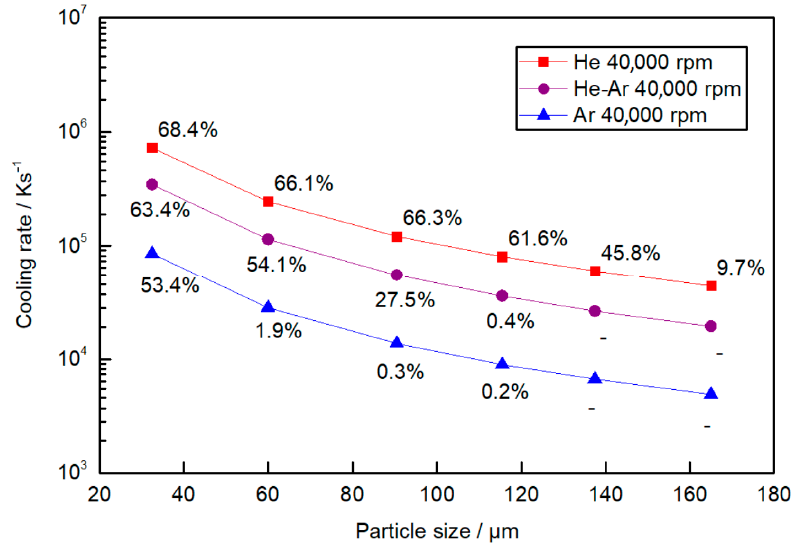
Figure 9. Cooling rate as a function of particle size atomized in a He, Ar, and He-Ar atmospheres at a disk speed of 40,000 rpm. The data points represent the amorphous fraction calculated from the DSC results for the corresponding mean particle size range.